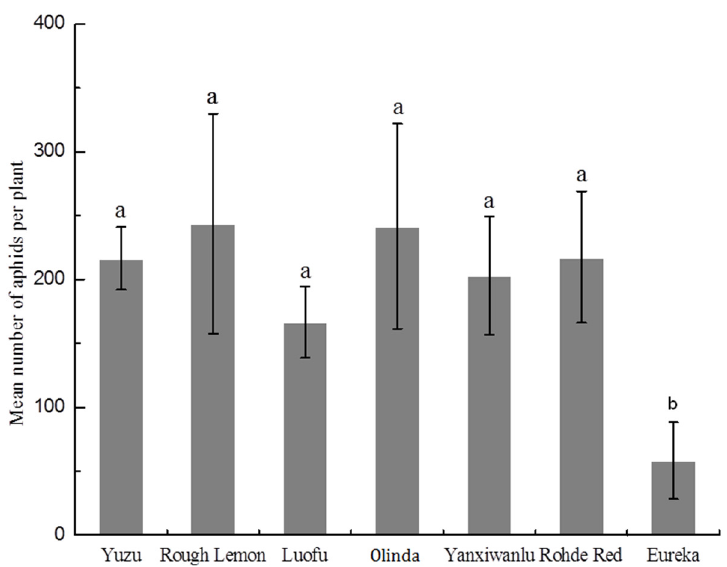
Figure 2. Mean number of aphids per plant on seven host plants after 8 days in a non-preference test under nonchoice conditions. Means ± SE ( n = 6) marked with the same letter do not differ significantly ( p > 0.05) based on one-way ANOVA with Fisher’s Protected LSD test.